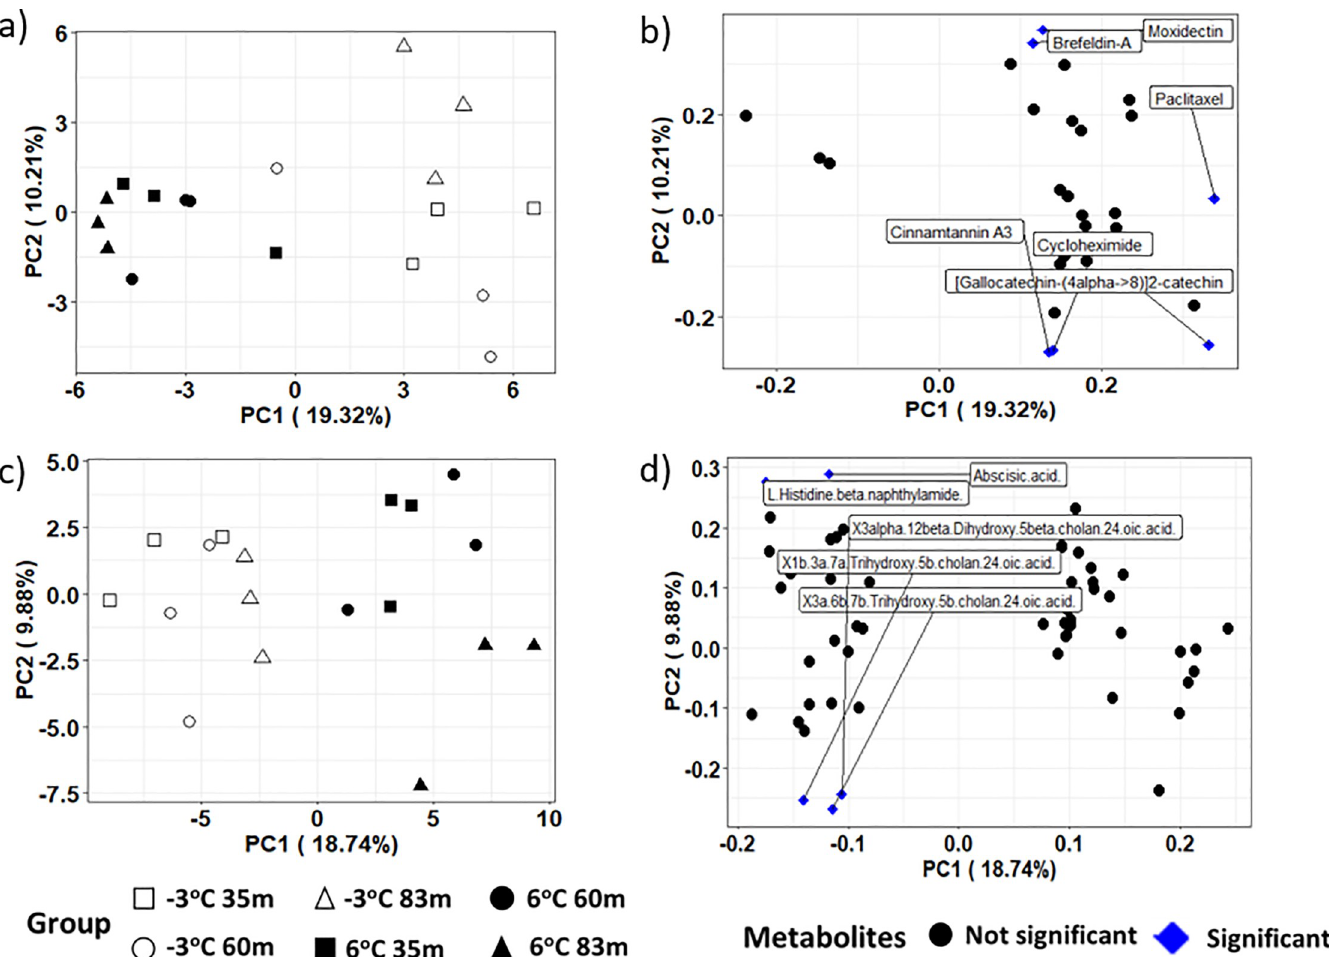
Fig 4. A 2-D plot of the first two principal component (PC) scores and loadings calculated from the filtered dataset of the metabolites in permafrost microbial cells at the three different sample locations and thawed from -3 o C to 6 o C. Figures a and b are the PC scores and loading from the ESI+ mode and figures c and d are the PC scores and loadings from the ESI- mode, respectively. Variables in the top or lower 10% of the PCA loadings are the significant metabolites and these significant metabolites are in brackets in the loading